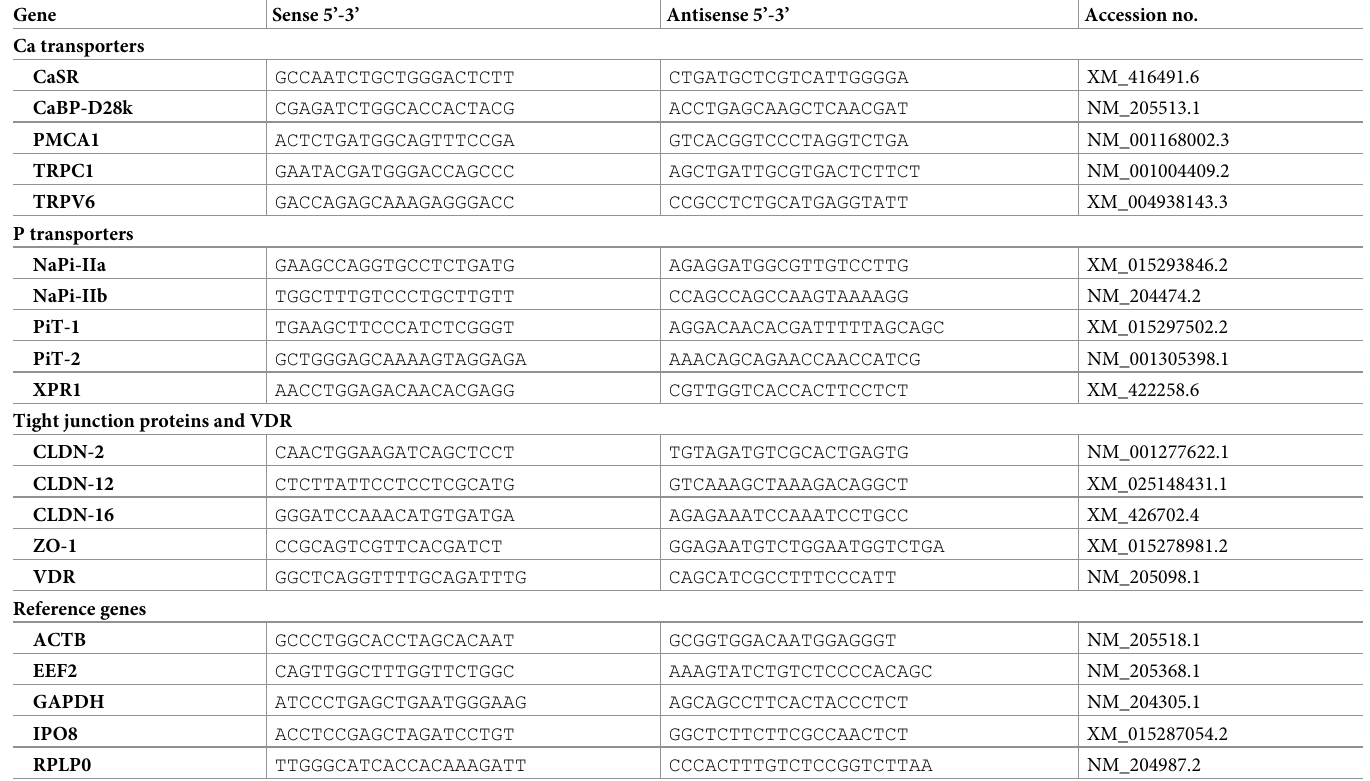
Table 1. Primers used for real-time quantitative PCR (RT-qPCR)